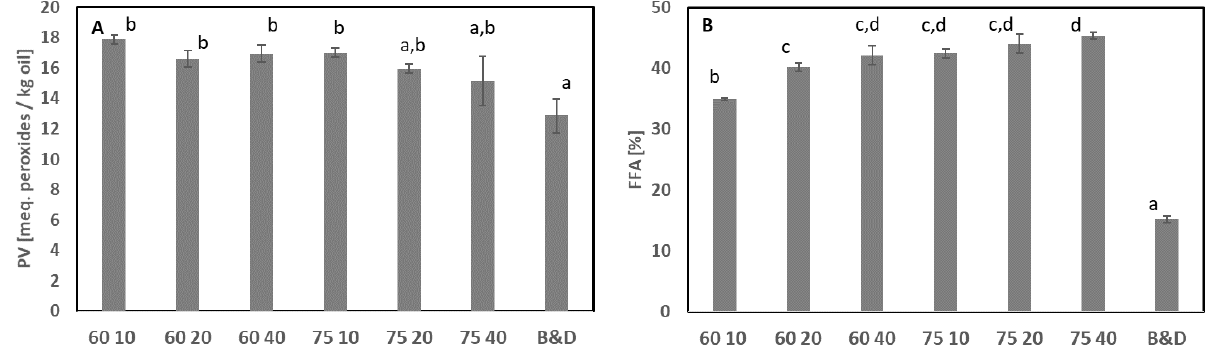
Figure 3. Effect of extraction conditions (temperature, 60 and 70°C; time: 10, 20, and 40 min) on oil quality when ethanol was used as the extraction solvent. The treatments were compared with B&D extraction (B&D). ( A ) Peroxide value (PV) and ( B ) free fatty acids (FFAs). Bars and error bars indicate the average (n = 2) and standard deviation. Different superscript letters indicate significant differences. Sample abbreviation: XX YY indicates temperature (°C) and time (min.), e.g., 60 10 is 60 °C for 10 mins. Starfish meal from December 2019 was used.